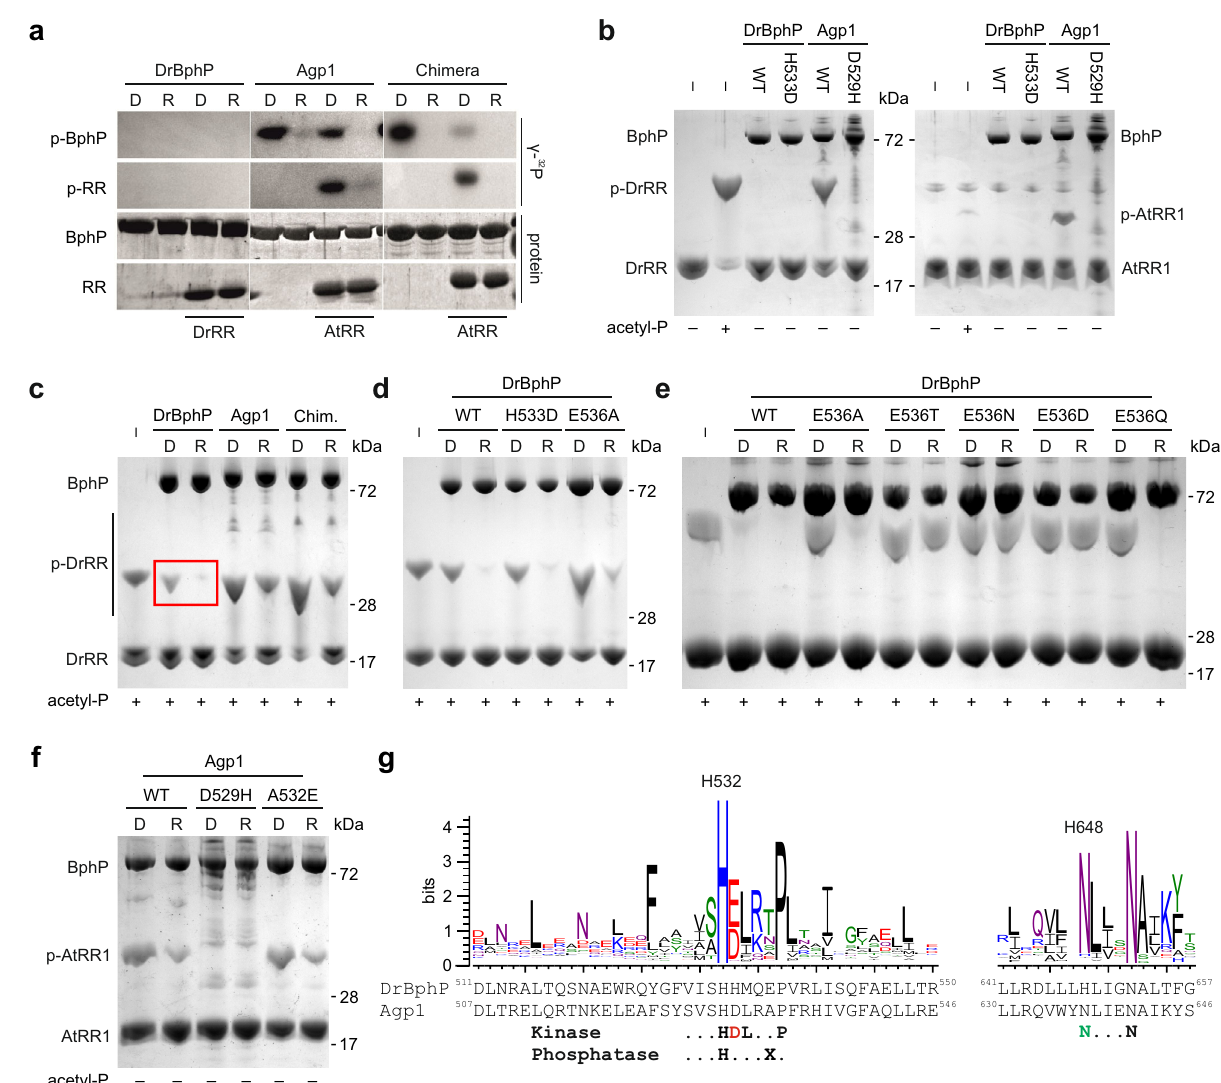
Fig. 3 Kinase and phosphatase activity of DrBphP and Agp1. a Kinase and phosphotransfer activity of the phytochromes (BphP), detected for radioactive phosphate ( γ - 32 P) and total protein. Each phytochrome sample was incubated with γ - 32 P-ATP, either with or without the response regulator (RR), DrRR in case of DrBphP, and AtRR1 in case of Agp1 and Chimera. Extended gels with molecular weight marker positions are shown in Supplementary Fig. 3. b Kinase activity in darkness of DrBphP, Agp1, and their variants with the H + 1 residue mutated. Each well was loaded with equal amounts of response regulator, all reactions contain ATP, and the total protein amount is visualized by protein staining. The phosphorylated response regulators (denoted p-DrRR and p-AtRR1) migrate more slowly in the gels and are therefore resolved from their unphosphorylated counterparts. c Phos-tag detection of the phosphatase activity of DrBphP (red box), Agp1, and Chimera. Equal amounts of phospho-DrRR were applied to each reaction. The letters D and R denote reactions performed in darkness or under red light, respectively. See Supplementary Fig. 4a for an extended gel. d Phosphatase activity of DrBphP and its variants H533D and E536A. Equal amounts of phospho-DrRR were applied to each reaction. See Supplementary Fig. 4b for an extended gel. e Phosphatase activity of additional DrBphP exchanges at the H + 4 position. f Kinase activity of Agp1 and its variants D529H and A532E. See also Supplementary Fig. 4h. g . Sequence logo of 250,000 histidine kinase sequences, shown here for the H box around the phospho-accepting histidine (H532 in DrBphP) and the N box in the CA subdomain. The height of each letter indicates the amount of conservation of the corresponding amino acid (one-letter code). The protein sequences of DrBphP and Agp1, and the fi ngerprint sequence motifs are shown below the graph. An aspartate residue in the H + 1 position is deemed important for histidine kinase activity 12 . In the case of phosphatase activity, the determinant residue at the H + 4 position 14 varies and is denoted as X. D = dark sample; R = red-illuminated sample. Positions of molecular weight markers are shown in panels ( b – f ), and all measurements of panels ( a – f ) have been repeated independently at least three times. Source data are provided as a Source data fi le, which include full versions of the